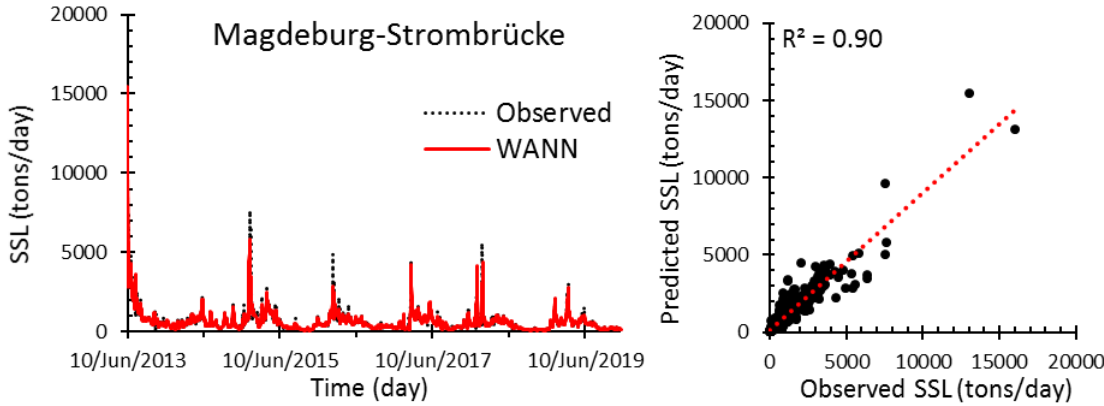
Figure 15. Observed versus predicted SSL of the best WANN model for the Pirna station in a testing phase.